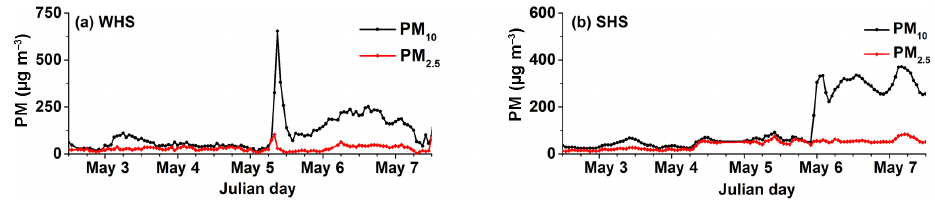
Figure 11. Time series of the PM 2 . 5 (red curves) and PM 10 concentrations (black curves) during 2–7 May at (a) WHS and (b) SHS.